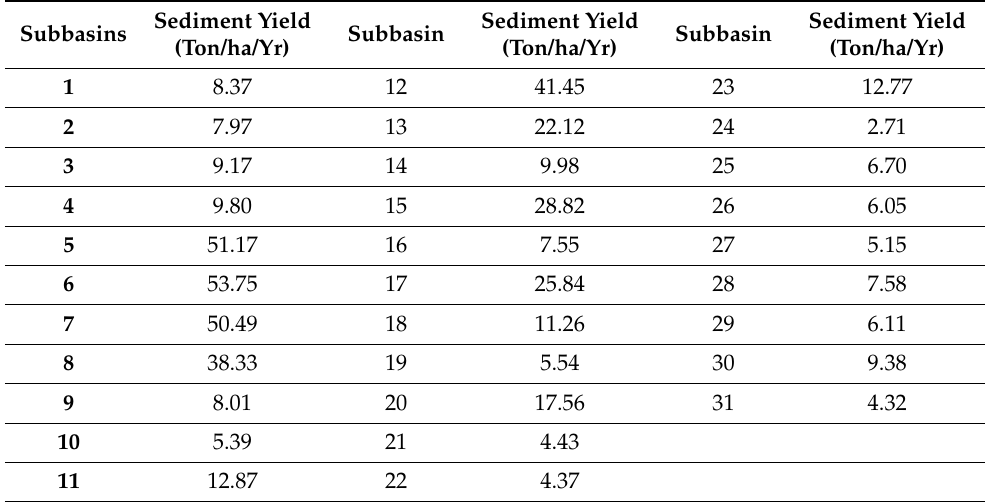
Table 9. Mean annual sediment yield of each subbasin in Genale Dawa-3 dam